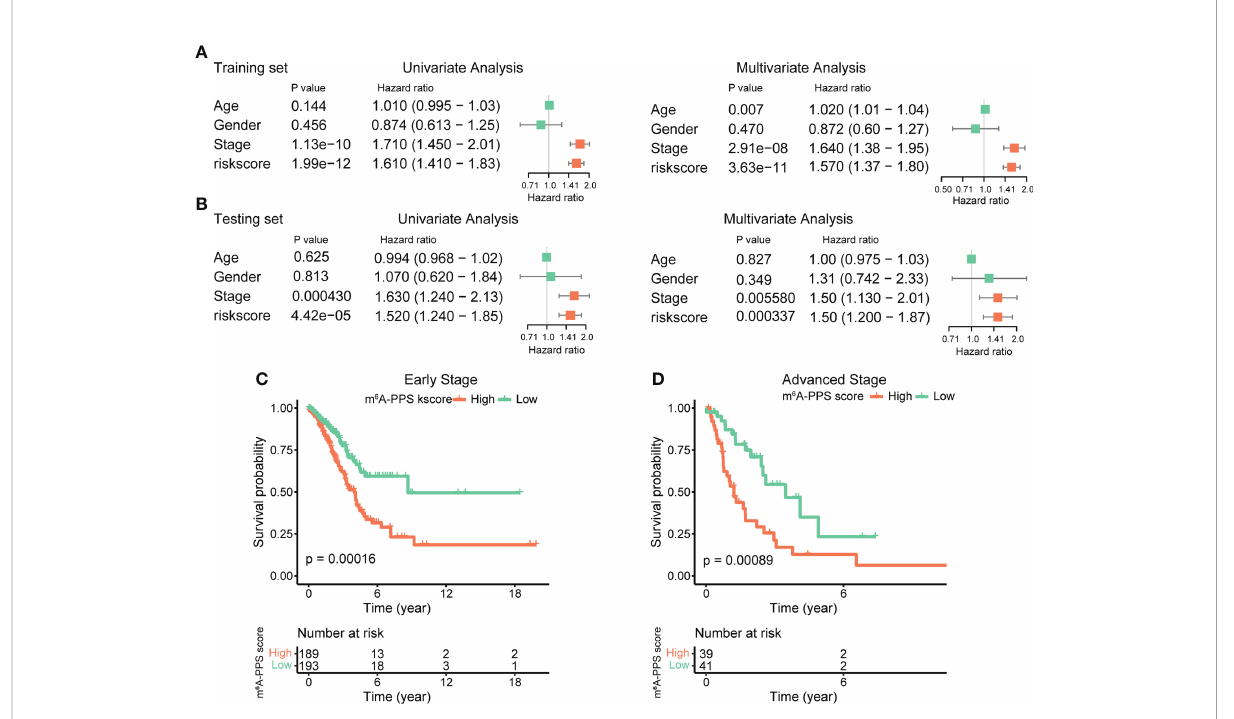
FIGURE 4 Assessment of the prognostic risk model of the m 6 A-RPS and clinical features. (A, B) Univariate and multivariate Cox regression analyses of correlations between the risk score for the m 6 A-RPS and clinical features in the training set (A) and validation set (B) . (C, D) Kaplan – Meier survival analysis of m 6 A-RPS prognostic value in stage I – II (C) and stage III – IV (D) patients in the TCGA LUAD